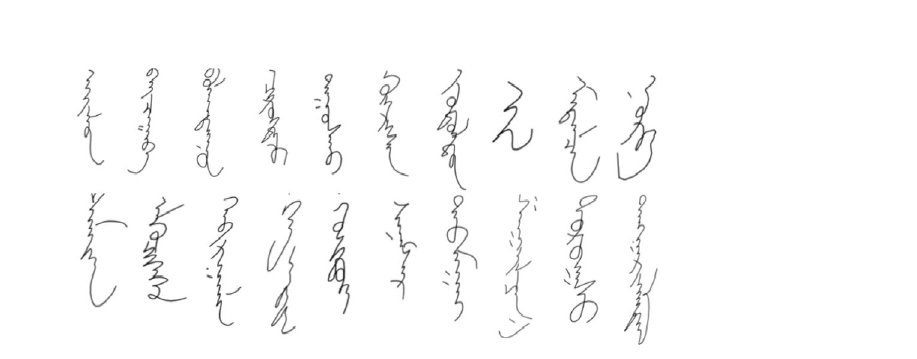
Figure 6. Some handwriting samples in